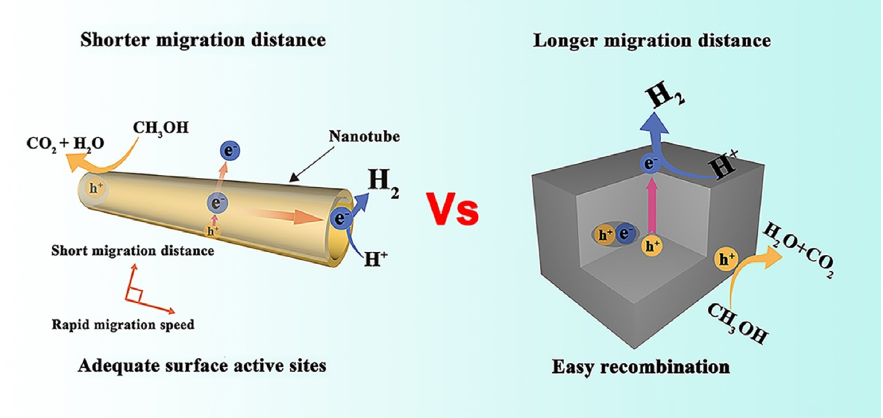
Figure 8. The schematic mechanisms of charge transfers in anatase TNTs under solar light irradia- tion ( left ) and charge recombination in the case of bulk titania ( right ). Copyrights 2021 Elsevier [113].